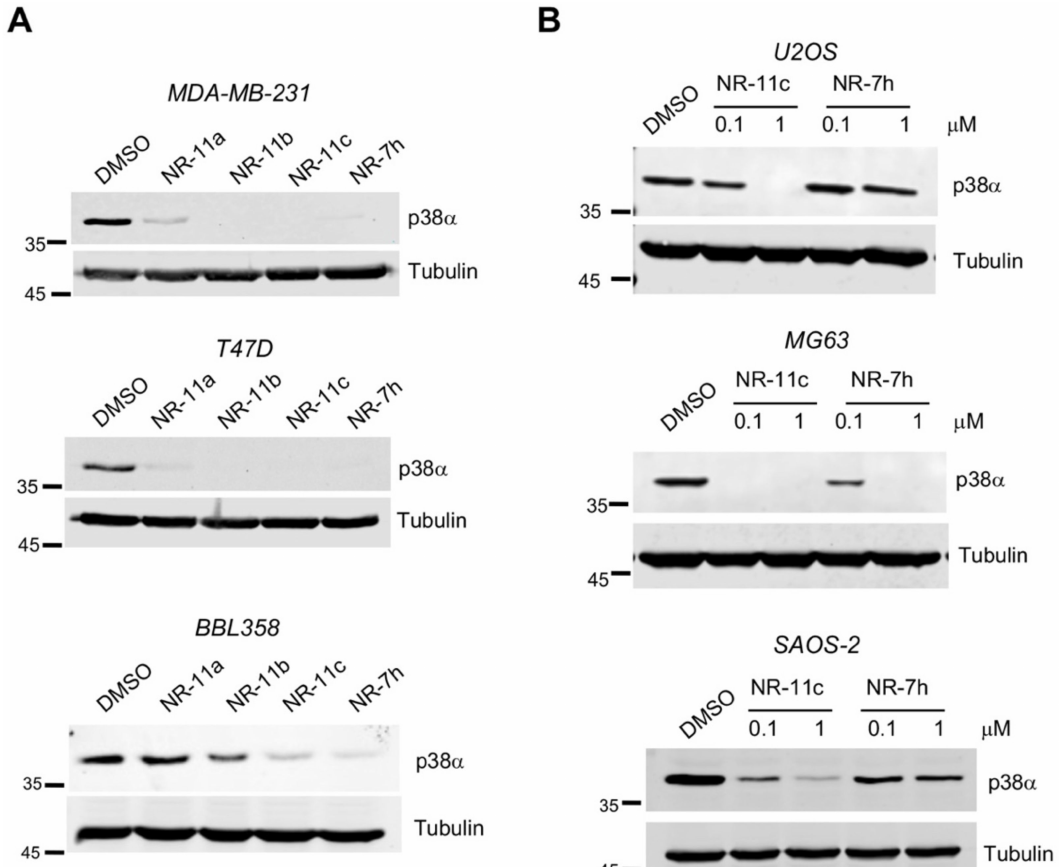
Figure 2. VHL-based PROTACs that target p38 α for degradation. ( A ) The indicated breast cancer cell lines were incubated with the indicated compounds at 1 µ M, and 24 h later, p38 α was analyzed in cells lysates by immunoblotting. ( B ) The indicated osteosarcoma cell lines were incubated with NR-11c and NR-7h at 1 or 0.1 µ M for 24 h and p38 α was analyzed in cells lysates by immunoblotting. Immunoblots were performed with a minimum of n = 2 biological replicates with similar results obtained each time. The uncropped blots are shown in Supplementary Materials File